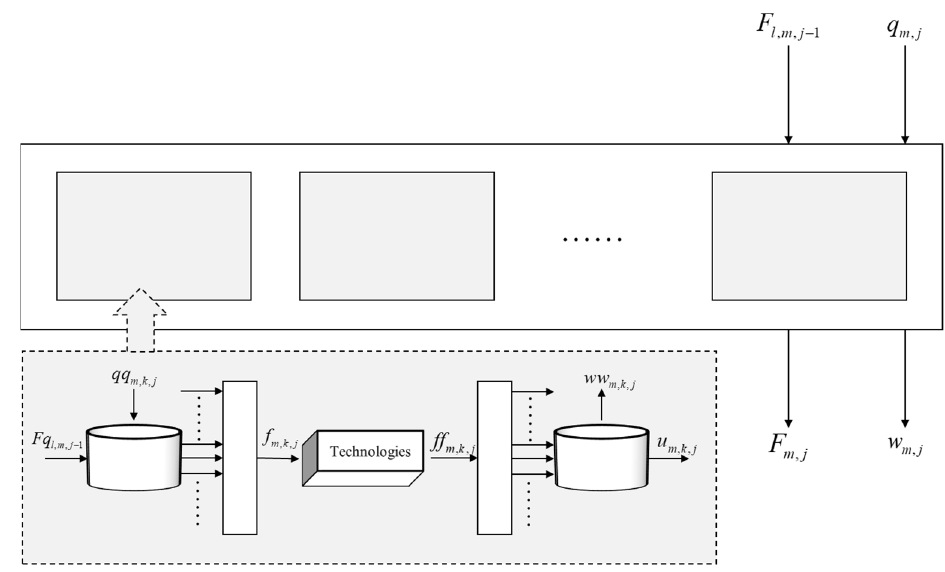
Figure 4. Representation of stage j and technological alternative k .